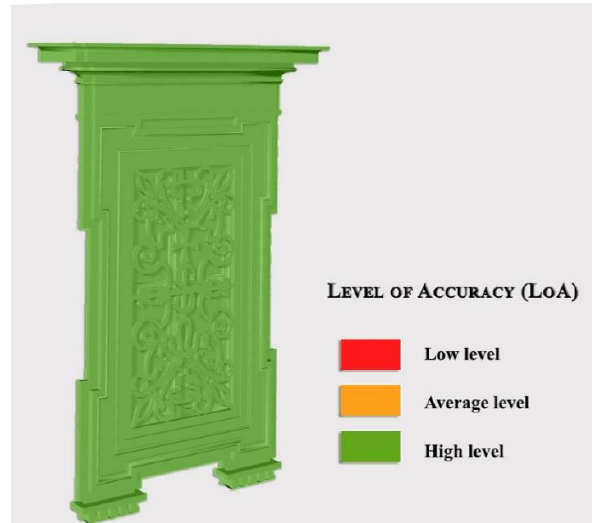
Figure 5: Level of Accuracy (LoA) of the model of St. Basilio’s window: High LoA, that is 70% of the model has a deviation less than 20 mm, and 30% with a deviation less than 50